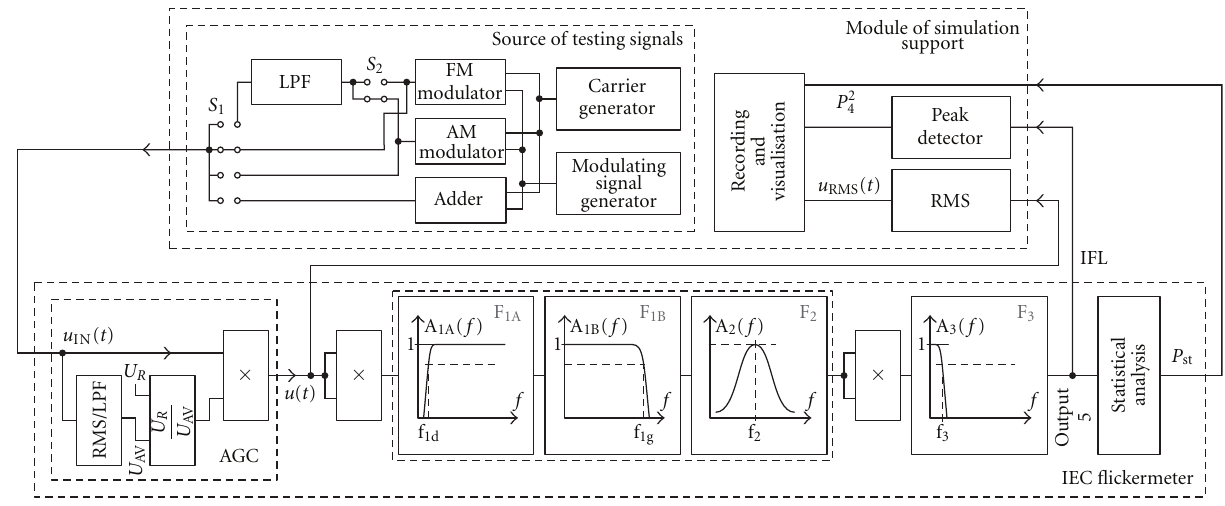
Figure 1: Block diagram of simulative test-bed for flickermeter signal chain testing: RMS—True RMS converter, RMS/LPF—True RMS converter with output low-pass filter, U R /U AV —signal divisor, U R —reference value, AGC—automatic gain control circuit, IFL— instantaneous flicker level, S 1 —selector of input signal u IN ( t ), S 2 —selector of input signal for LPF filter.